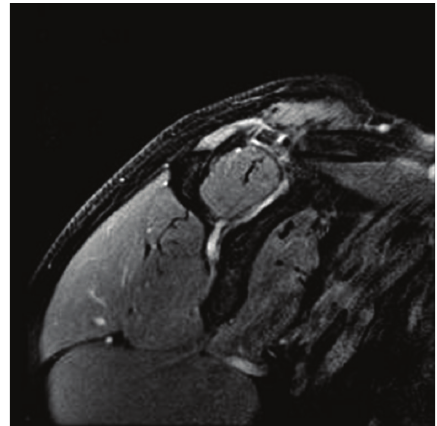
Figure 3: Magnetic resonance imaging of the acromioclavicular joint in DP fat-suppression sequence demonstrates the osteolysis with no soft tissue reaction or bone